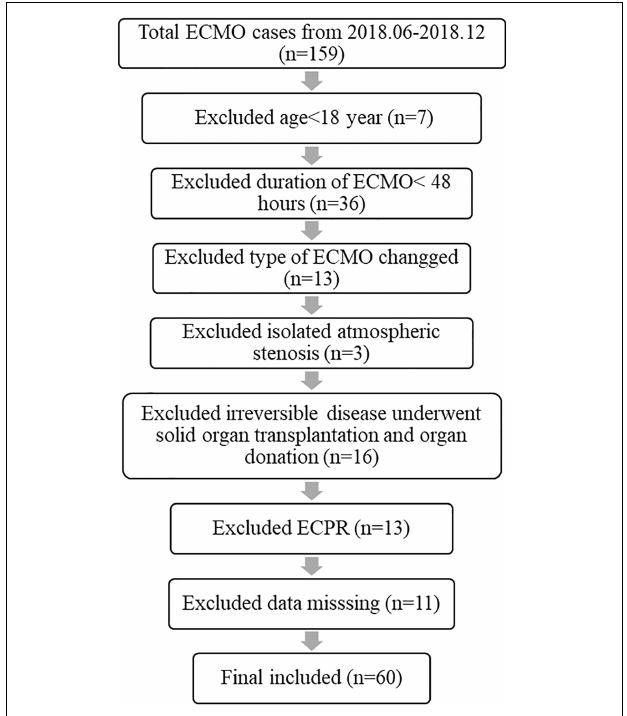
FIGURE 1 | Flow diagram of patient enrolment. ECPR, extracorporeal cardiopulmonary resuscitation.